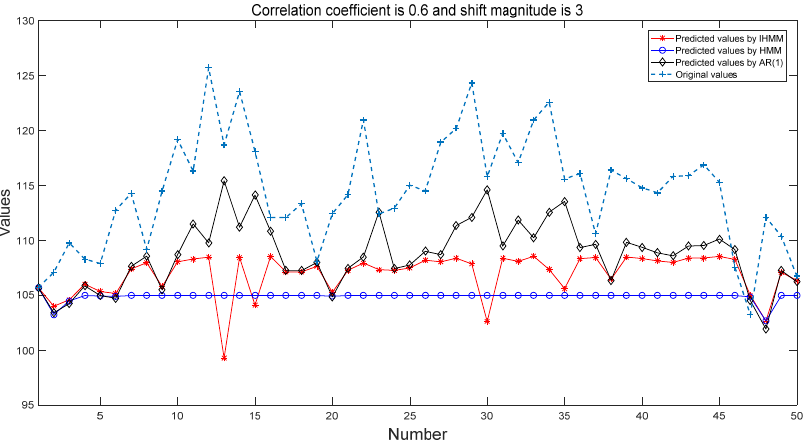
Figure 5. The predicted results of three models under an out-of-control process.